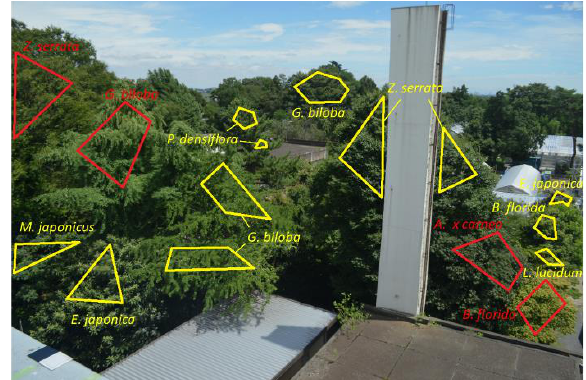
Figure 3. Diurnal differences of 4 indices on 21 st July (clear sky)